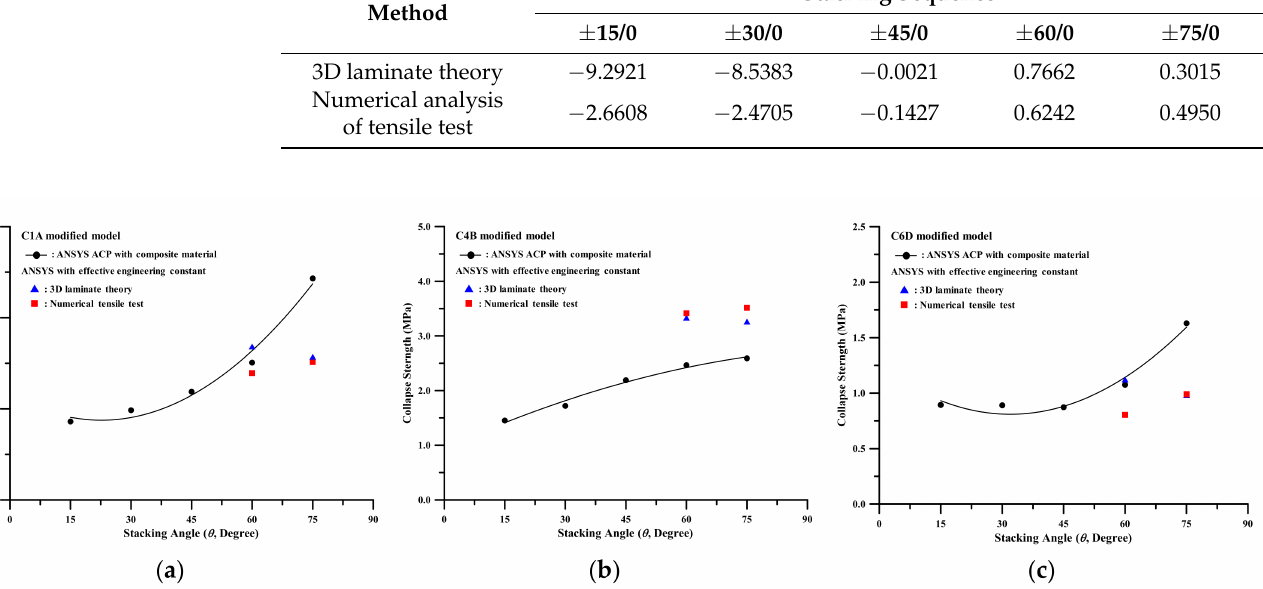
Figure 18. A comparison of the collapse strength using the effective engineering constant. ( a ) Modified C1A, ( b ) Modified C4B, ( c ) Modified